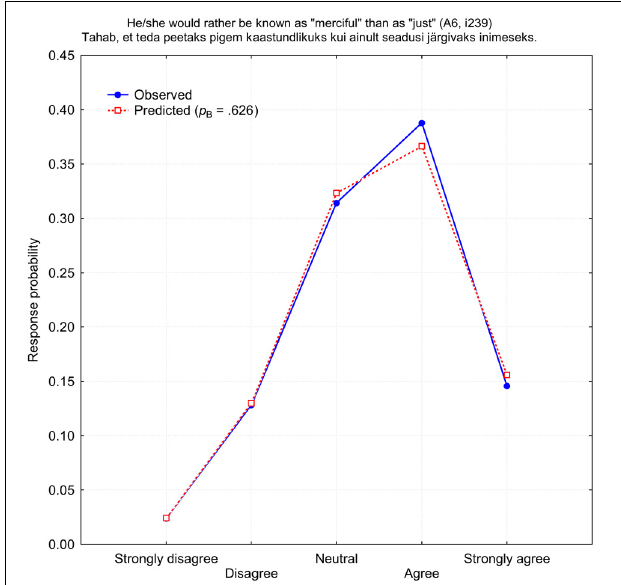
FIGURE 3 | The patterns of χ 2 growth on a logarithmic scale for 1PBM, 2PNM, and 3PBM separately for self (continuous lines) and other (broken lines)